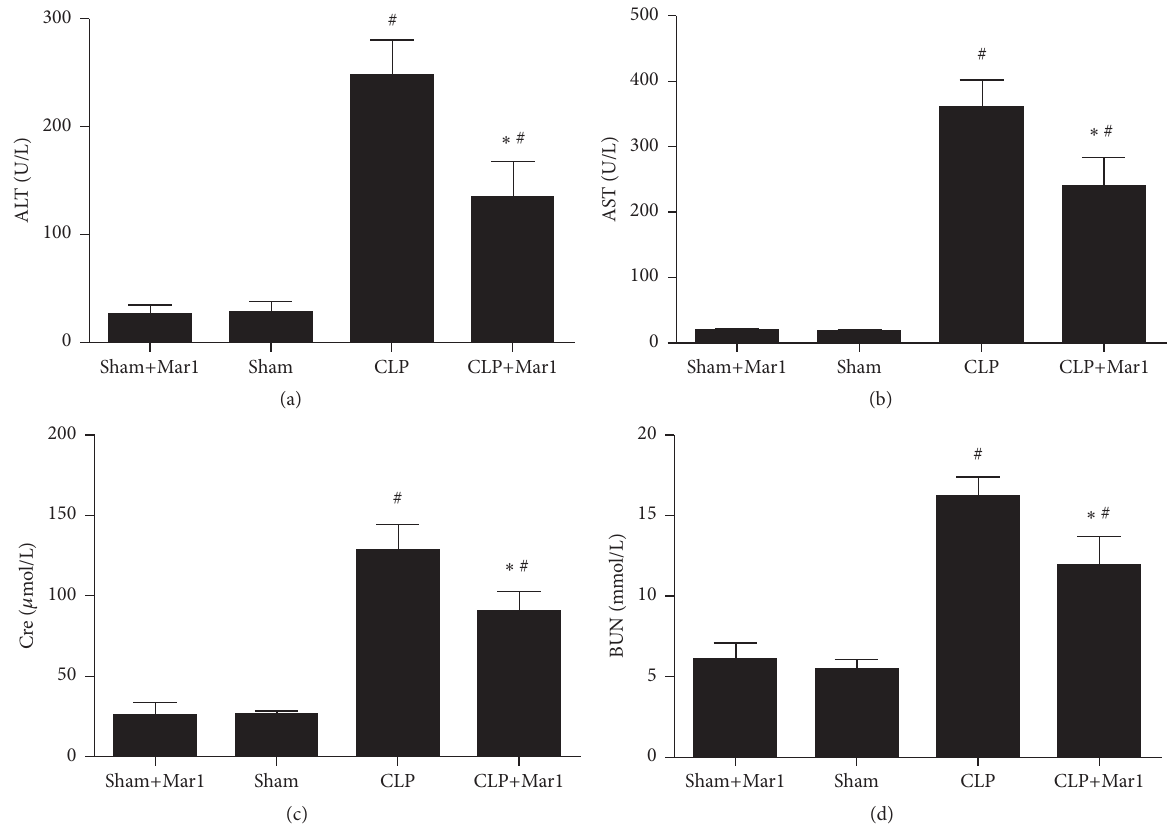
Figure 5: Improvement of liver and kidney functions of mice by Mar1 after CLP surgery. The change of serum ALT (a) and AST (b) activities by Mar1 in CLP mice. The change of Cre (c) and BUN (d) in serum by Mar1 in CLP animals. 𝑛 = 6 . Data are expressed as means ± SEM. # 𝑃 < 0.05 versus the sham group. ∗ 𝑃 < 0.05 versus the CLP group.